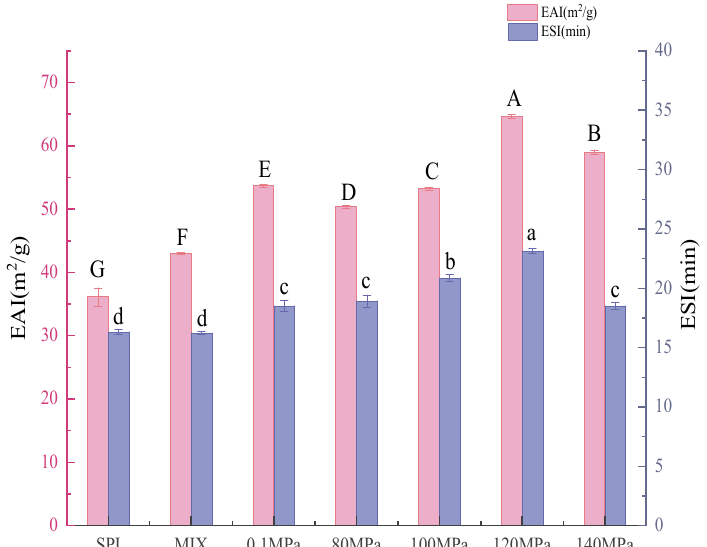
Figure 9. Emulsifying properties of the samples. SPI is the native soy protein isolate; MIX represents the mixture of SPI and GOS; 0.1 MPa represents the traditional wet heating Maillard reaction group; 80 MPa, 100 MPa, 120 MPa, and 140 MPa are the HPH treatment groups. The letters a–d and A–G indicate decreasing orders of magnitude ( p < 0.05).